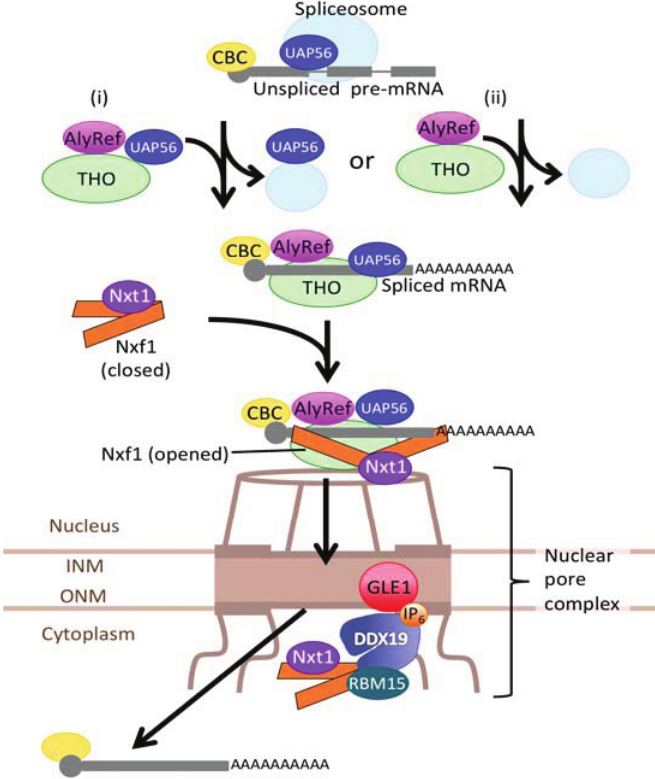
Figure 2. Nxf1-dependent mRNA export. Nascent pre-mRNA is spliced by the